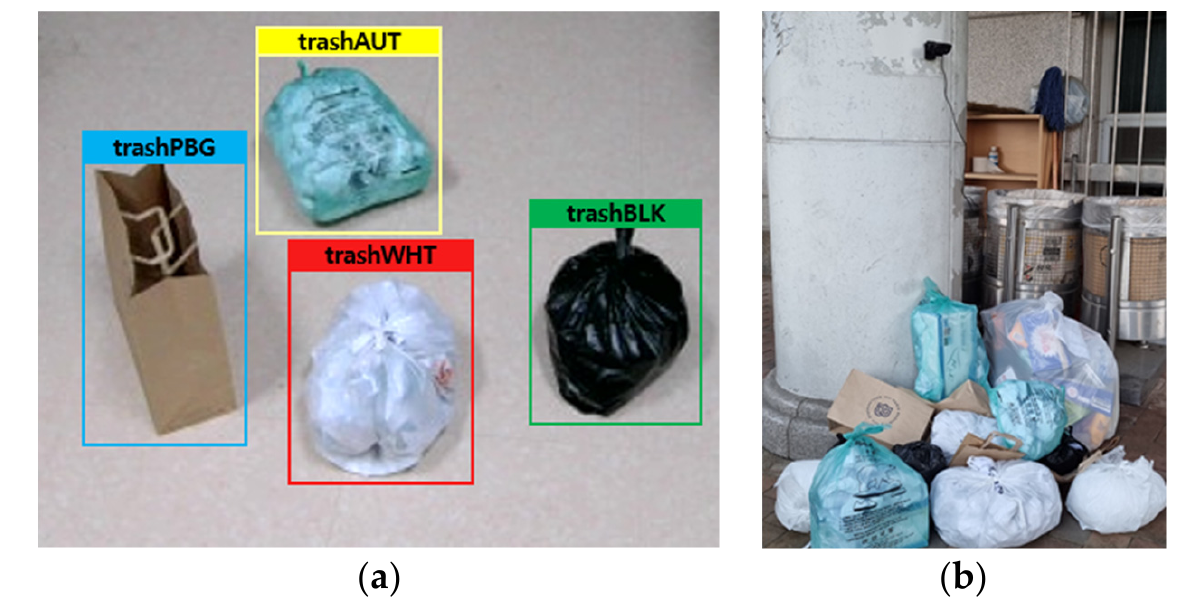
Figure 4. The environment for the collection of illegal dumping data and scenario ‐ based evaluation; ( a ) standard and non ‐ standard garbage bags used in the training and the evaluation; ( b ) data col ‐ lection environment.